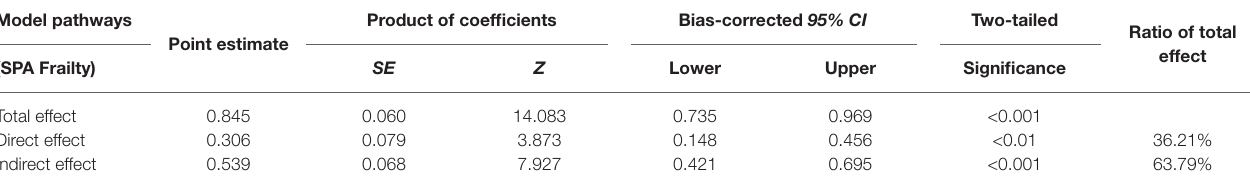
TABLE 4 | Bootstrapping total, direct, and indirect effects and 95% Confidence Interval (CI) for the mediation model. Model